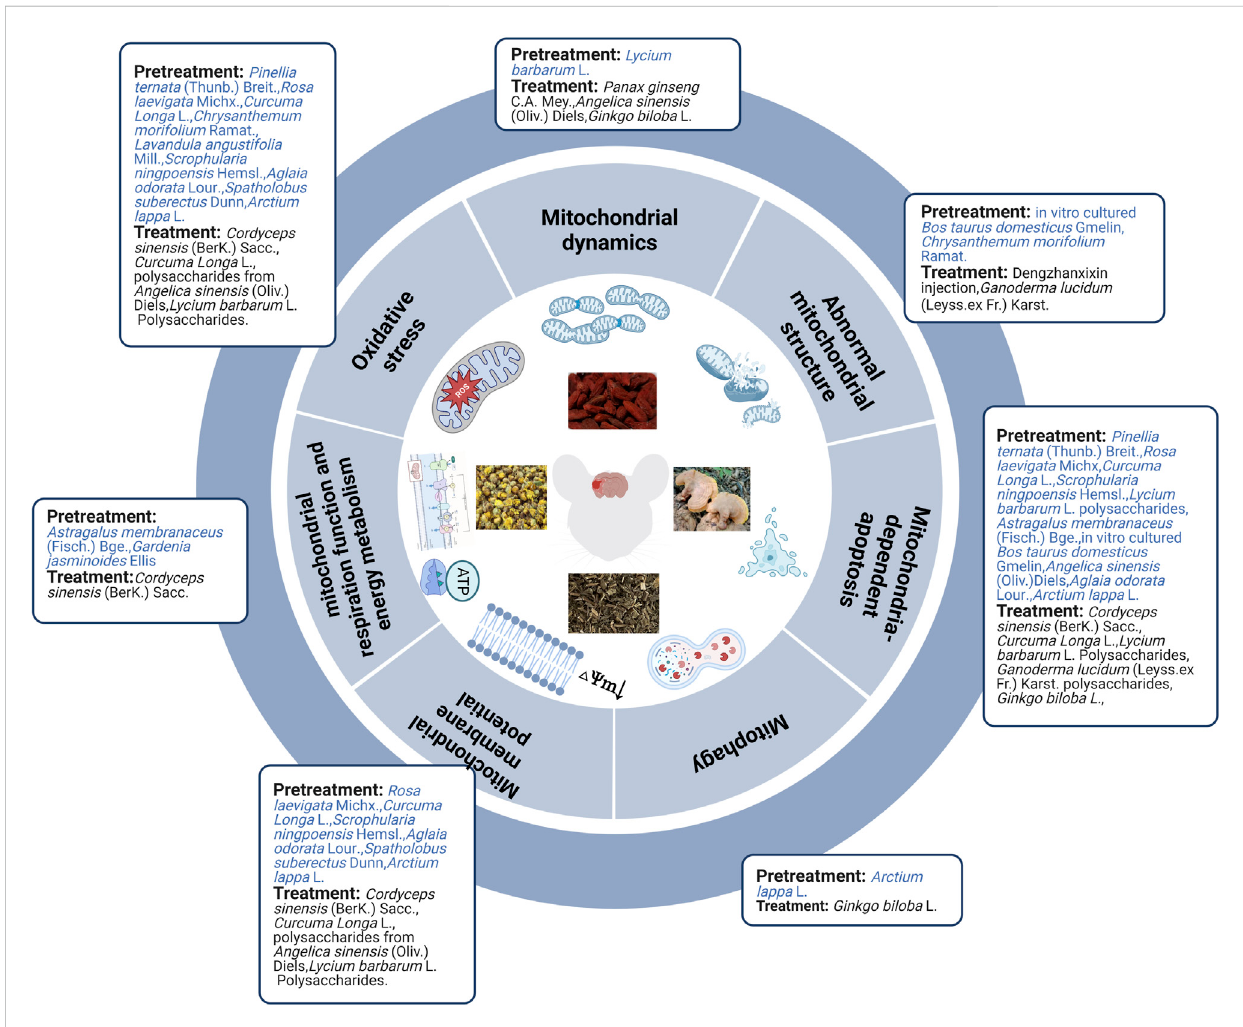
Herbal extract prevented and treated ischemic stroke by regulating